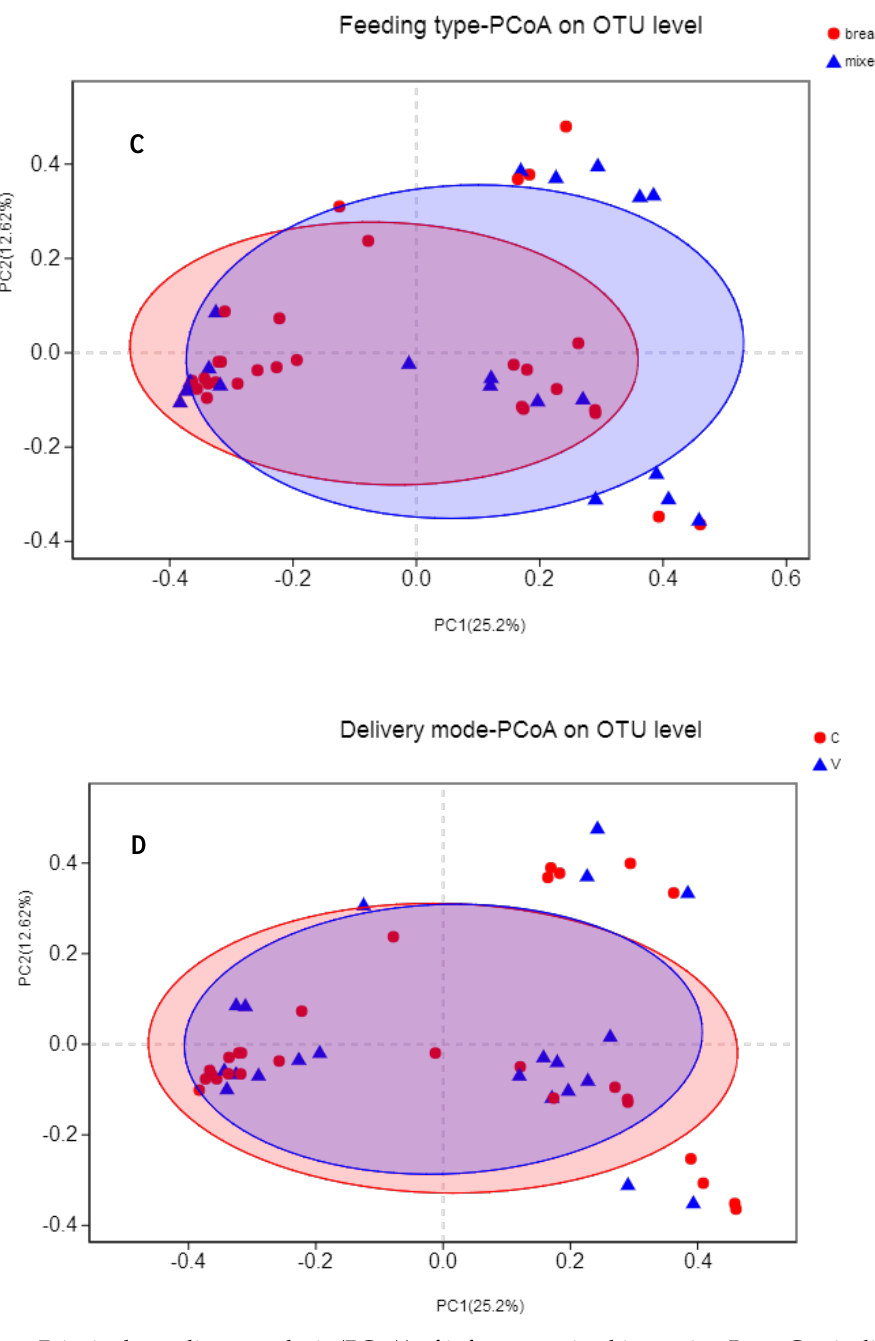
Figure 2. Principal coordinate analysis (PCoA) of infant gut microbiota using Bray–Curtis distance matrix. Two-dimensional PCoA was used to describe the relative abundance of infant gut microbiota. Each point represents a single sample and is colored by different groups ( A) antibiotic exposure; ( B ) probiotic consumption; ( C ) feeding type; ( D ) delivery mode.